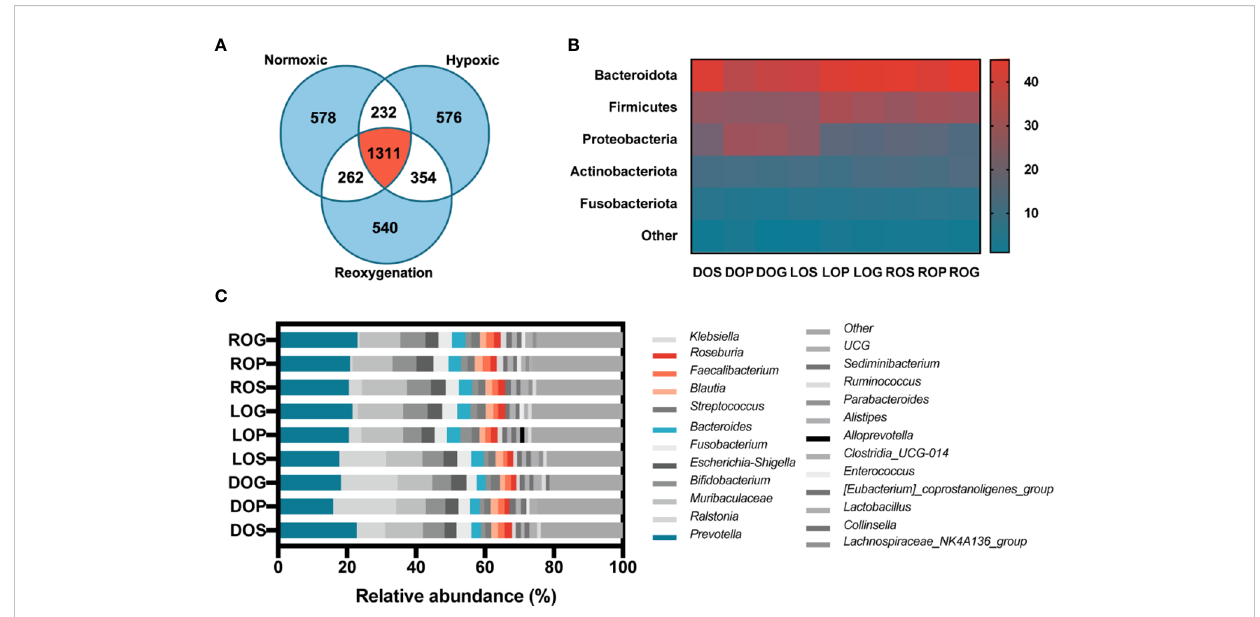
FIGURE 2 Gastrointestinal microbial structure (A) Venn diagram of the number of OUTs between different groups (B) Heat map of relative abundance at the phylum level (C) Structure of relative abundance at the genus level. DOS, DOP, and DOG are the stomach, pyloric caecum, and intestine of the normoxic group, respectively, LOS and ROS, etc. are the gastrointestinal samples of the hypoxic and reoxygenated groups.